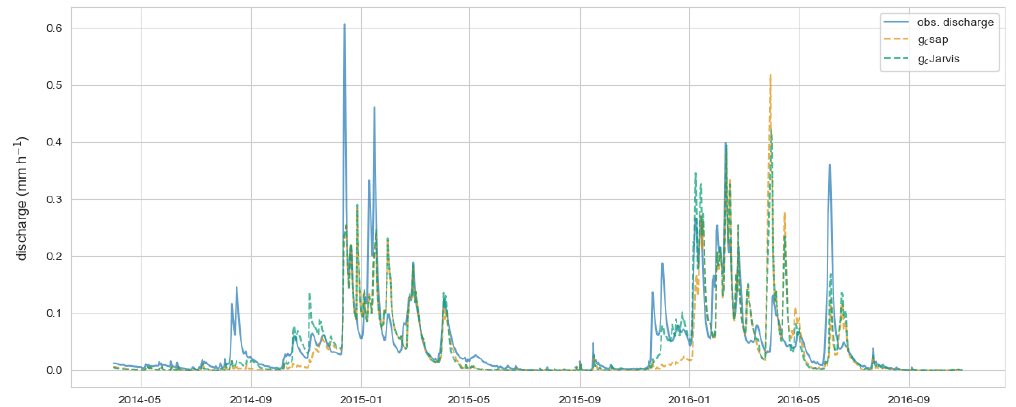
Figure A2. Observed discharge of the Weierbach catchment, simulated discharge of the benchmark model ( g c Jarvis), and simulated dis- charge of the model–data integration that uses g c sap to estimate